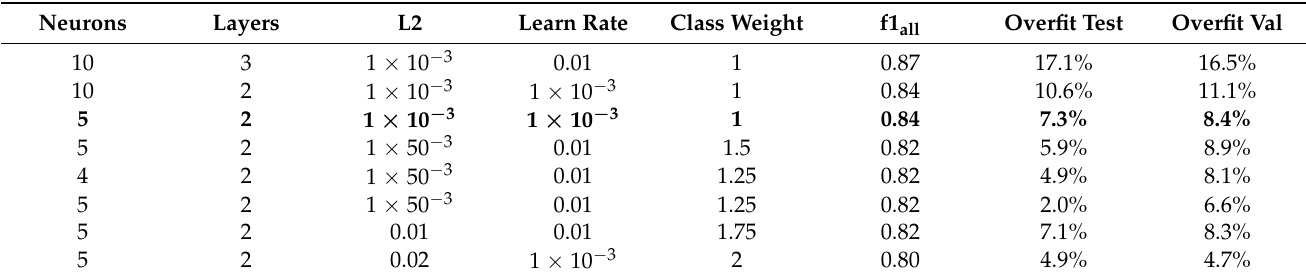
Table 6. Hyperparameters and f1 metrics for the best family of NN models. Metrics are presented for the entire dataset (f1 all ), and the percent overfitting on the test and holdout datasets, based on the f1 metric. Bold text indicates the best model. Neurons Layers